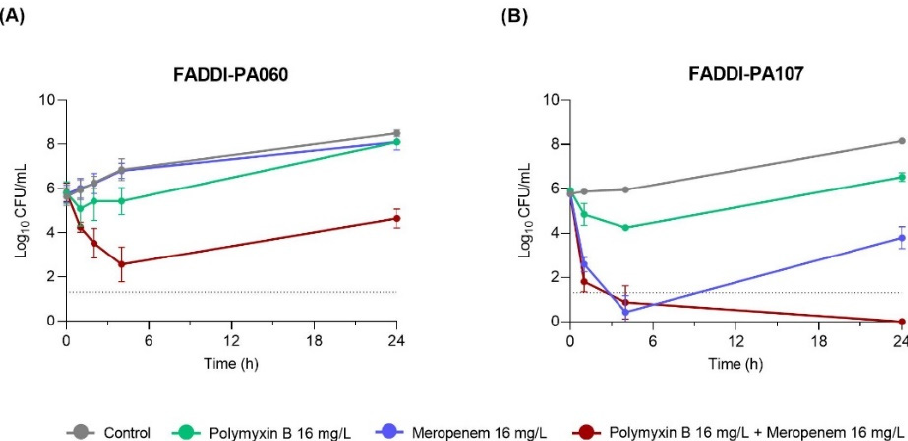
Figure 6. Time-kill curves of FADDI-PA060 ( A ) and FADDI-PA107 ( B ) with polymyxin B 16 mg/L and meropenem 16 mg/L, alone and in combination, at an inoculum of ~10 6 CFU/mL. The limit of detection is shown by the dotted horizontal line at 1.30 log 10 CFU/mL. Time-kill studies were performed in triplicate and data are presented as mean ± SD ( n = 3).